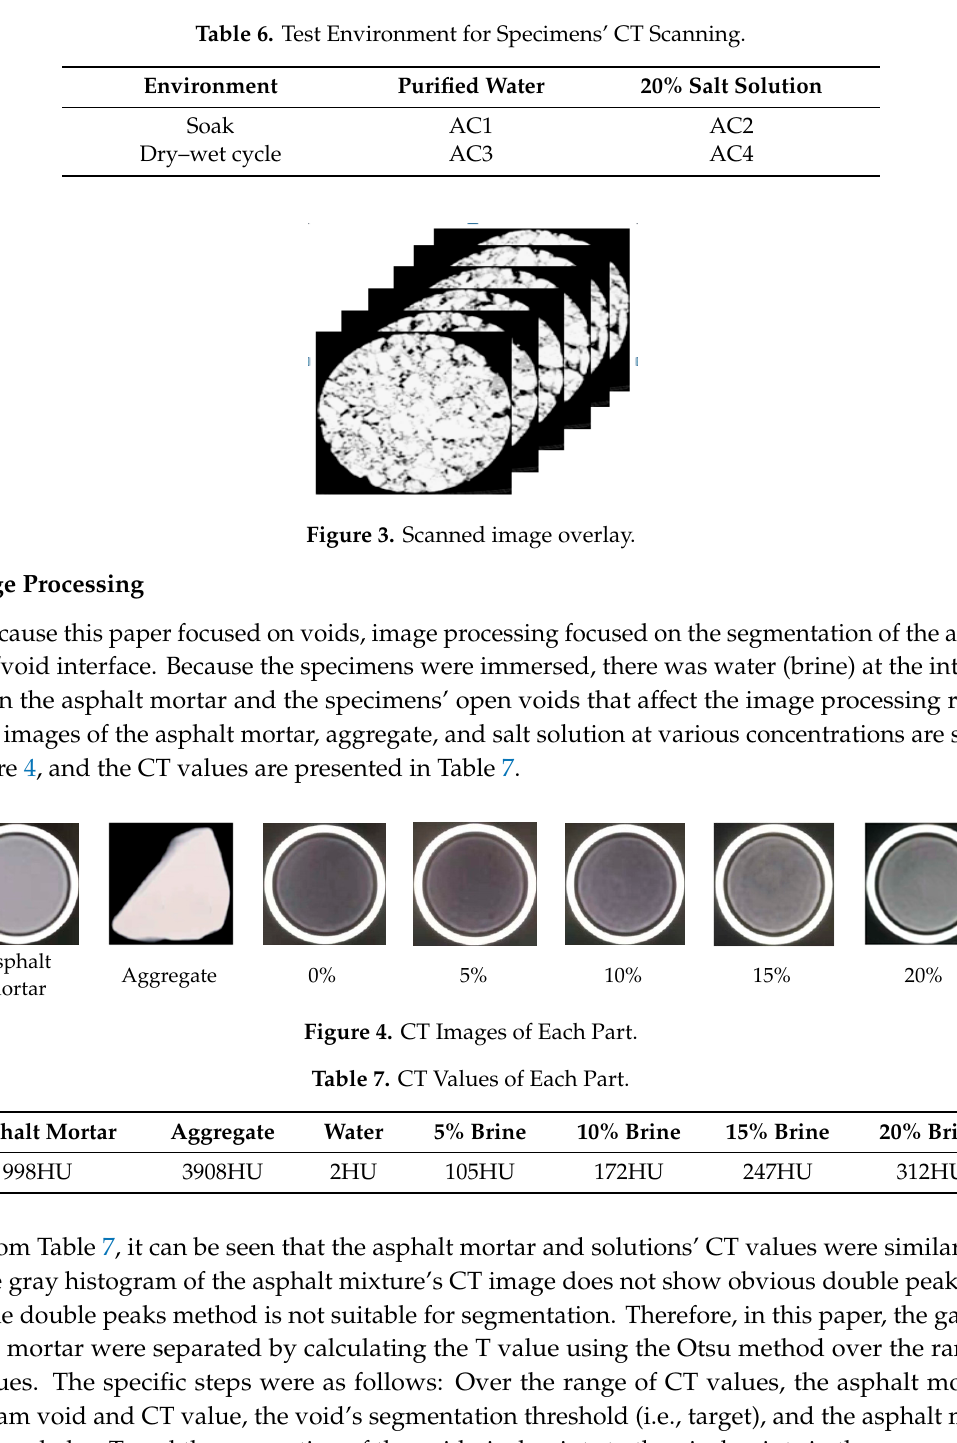
Table 6. Test Environment for Specimens’ CT Scanning.